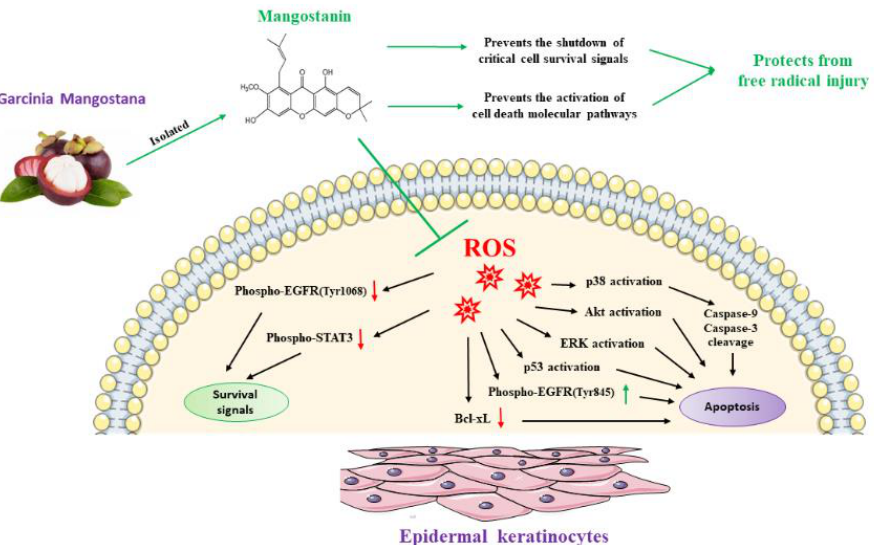
Figure 7. The xanthone mangostanin, isolated from Garcinia mangostana fruit, showed different protective effects against the cytotoxicity exerted from H 2 O 2 . Briefly, we showed that mangostanin prevents the shutdown of critical cell survival signals as the phosphorylation of EGFR on Tyr1068, STAT3, prevents the activation of p38, p53, AKT, ERK, the phosphorylation of EGFR on Tyr845, and the cleavage of caspase-9 and caspase-3, thus increasing cell vitality.